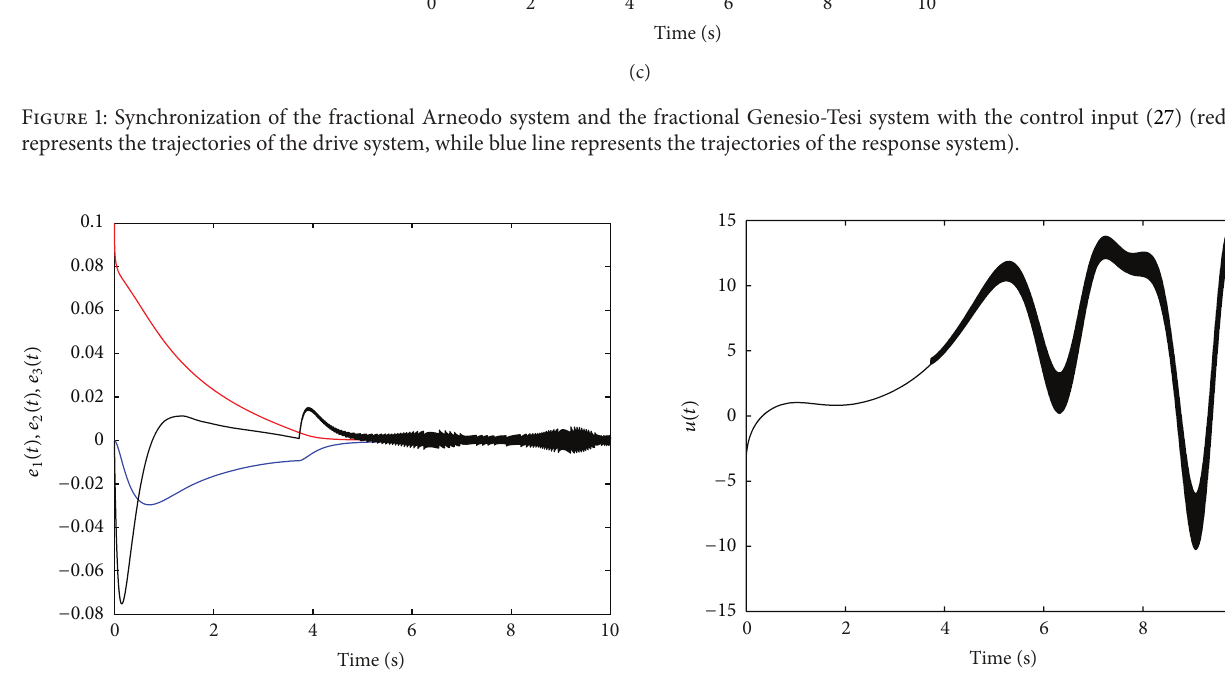
Figure 2: Synchronization errors with the control input (27) (red line represents the first error state 𝑒 1 , blue line represents the second error state 𝑒 2 , and black line represents the third error state 𝑒 3 ).